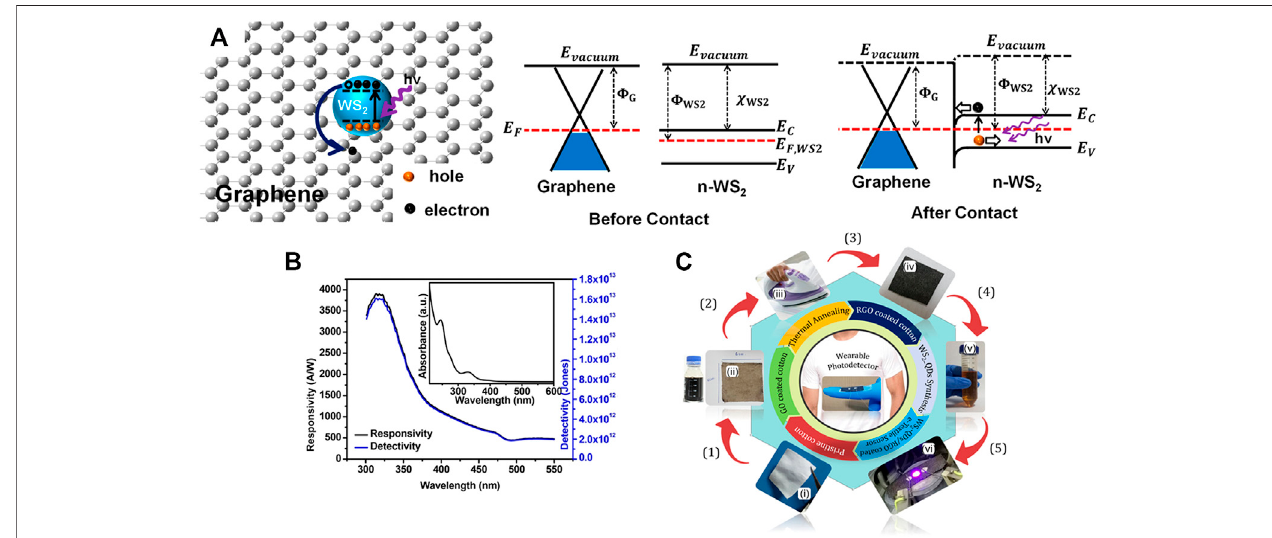
FIGURE 10 | (A) Schematic of dispersed WS 2 QD on the graphene layer. The energy band diagrams of WS 2 QDs/graphene heterojunction before and after contact. (B) ResponsivityanddetectivityofthePDwithanabsorptionspectrumofWS 2 QDsintheinset. (C) Schematicillustrationofproceduresinvolvedinsynthesizing WS 2 -QDs decorated RGO e-textile – based PD. Images of ( ⅰ ) pristine cotton textile, ( ⅱ ) cotton textile coated with GO, ( ⅲ ) iron used for thermally reducing GO, ( ⅳ ) GO (or RGO) after thermal reduction, ( ⅴ ) synthesized solution of WS 2 QDs, and ( ⅵ ) fabricated PD based on WS 2 QDs/RGQ heterostructure. (a) – (b) Reprinted with permission from ACS Appl. Nano Mater., 2019, 2, 3934 – 3942. Copyright 2019 American Chemical Society. (c) Reprinted with permission from ACS Appl.